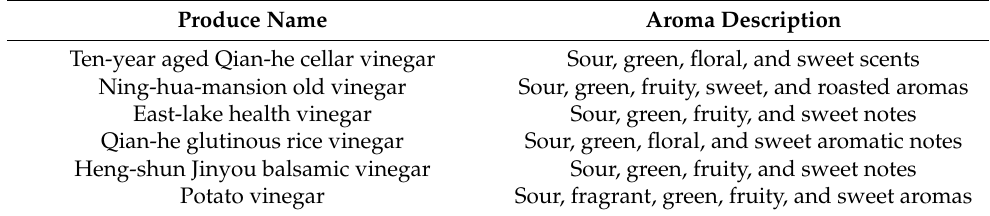
Table 6. Aromatic features of six kinds of vinegar.